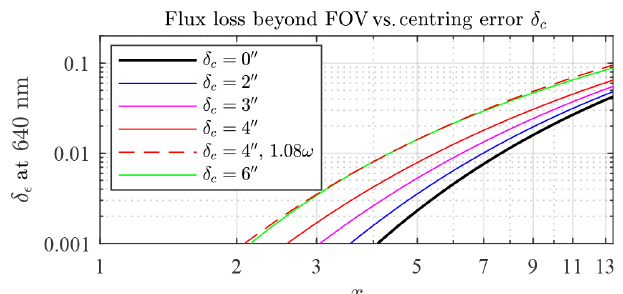
Figure 18. Observation error due to throughput degradation at Eu- reka when using the SPST09/C11 system. This error is the result of a FOV that is too small combined with a centring error (see the main text for details).(Note that “ (cid:48)(cid:48) ” denotes arcseconds in this figure.)